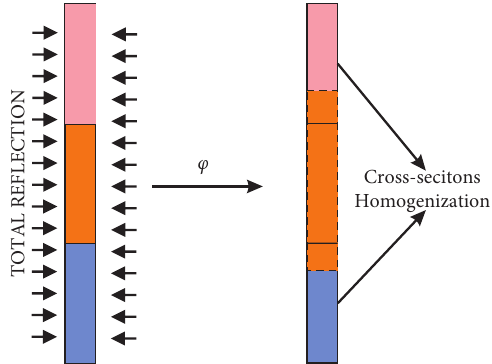
Figure 6: Cross-section homogenization process.